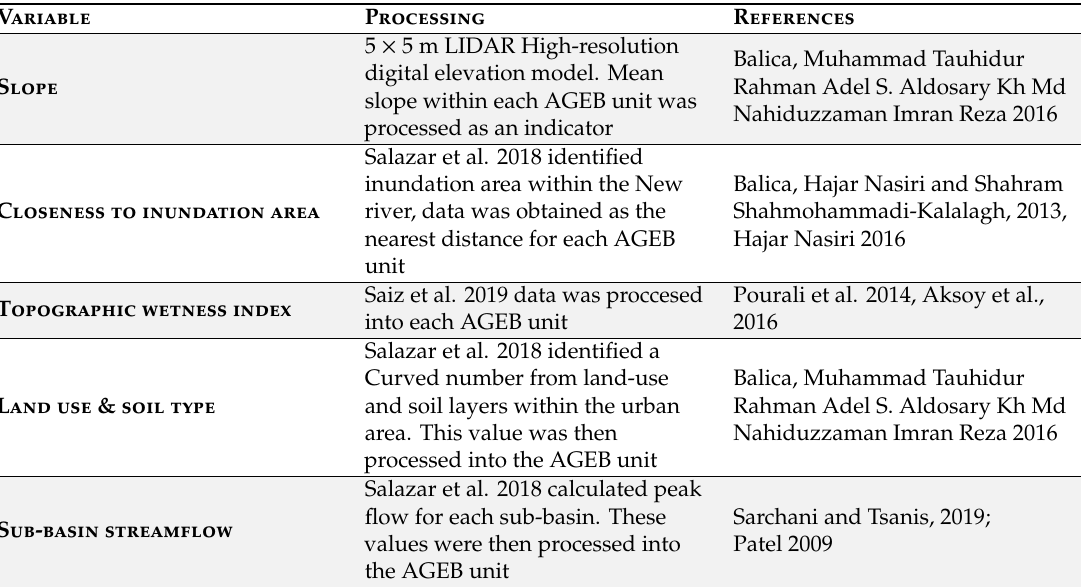
Table 3. Physical component